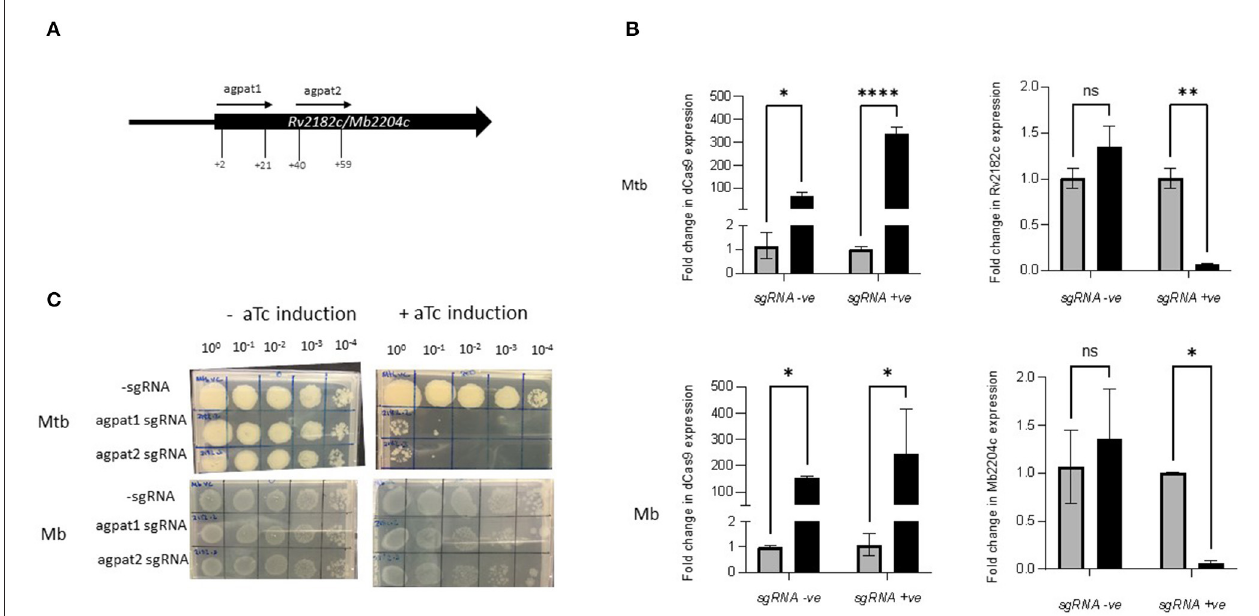
FIGURE 4 | Using CRISPRi/dCas9 to inhibit Rv2182c/Mb2204c expression in M. bovis and M. tuberculosis. (A) Schematic showing the target regions of two sgRNAs designed to target and inhibit Rv2182c/Mb2204c expression. The numbers show the nucleotide position of the sgRNA relative to the annotated start site (B) dCas9 expression and Rv2182c/Mb2204c expression were measured by RT-qPCR as described in the methods section. Expression levels were measured in the strain expressing sgRNA agpat1. Gene expression was analysed using the 2 − 11 CT method, normalised against sigA . Results represent two biological repeats with two technical repeats each. * P < 0.05, ** P < 0.01, *** P < 0.001, **** P < 0.0001 or not significant (ns), analysed using a 2-way ANOVA test. Black bars represent aTc treated cultures and grey bars untreated. (C) CRISPRi strains were cultured in 10ml of supplemented 7H9 medium to exponential phase and diluted to 2 × 10 7 CFU/ml. A 10-fold serial dilution to 10 − 4 was performed and 20 µ l of each dilution was spotted onto 7H11 agar without aTc and with 200ng/ml aTc to induce CRISPRi/dCas9 and the sgRNA in those strains that carried the guide. Two biological replicates were carried